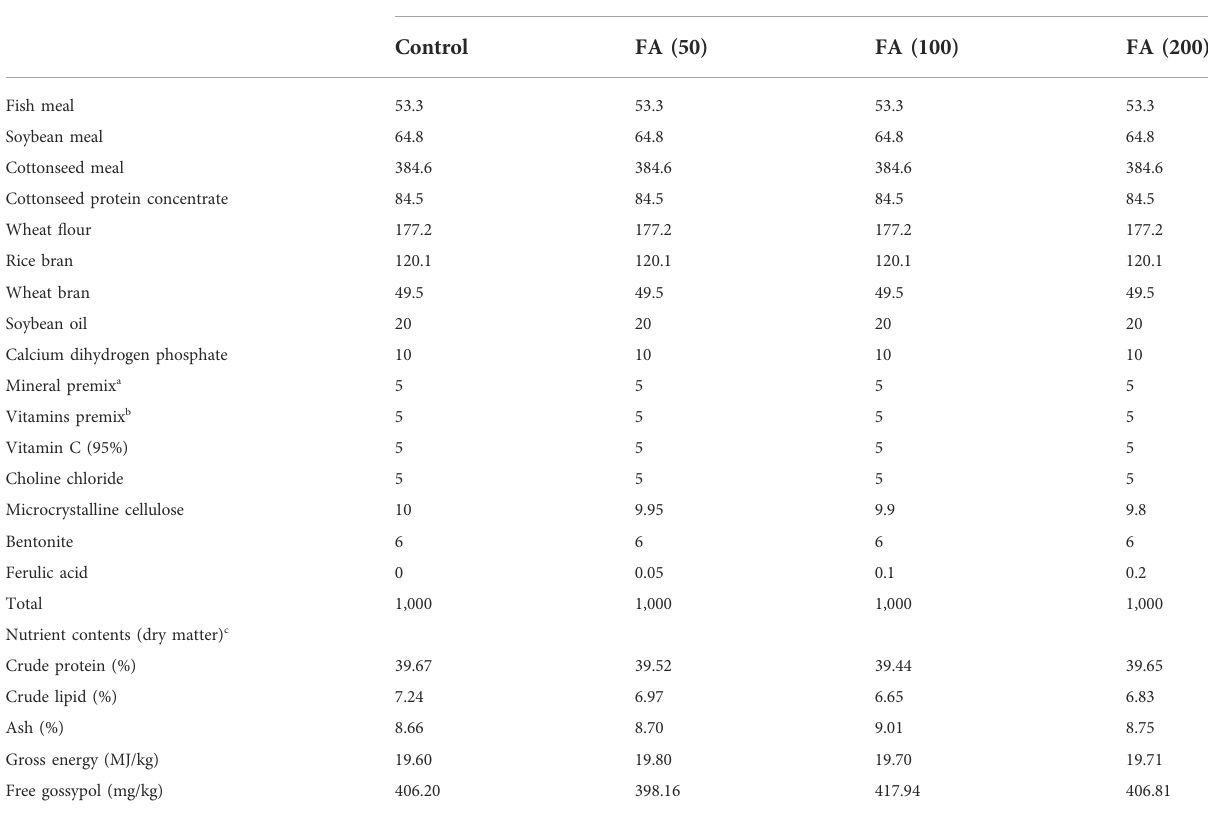
TABLE 1 Ingredient and nutrient composition of experimental